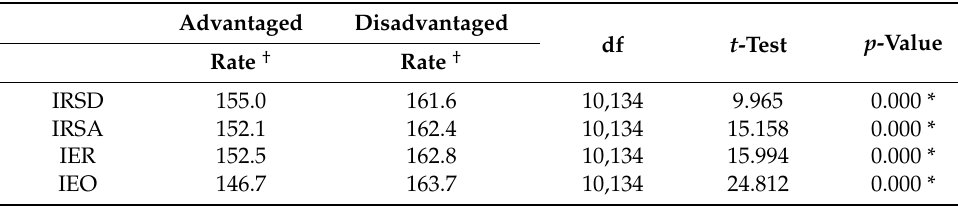
Table 3. Injury rate differences between Advantage and Disadvantage throughout the study area (all health services).